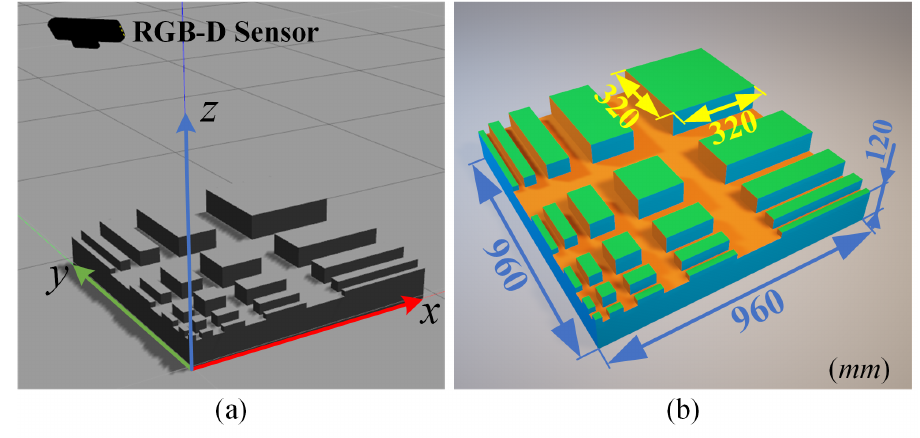
Figure 8. ( a ) The synthesized scene in Gazebo, where the pattern object is perceived by a simulated RGB-D sensor. The edges of the object’s base are respectively aligned with the x and y axes of the reference frame, while the edge orthogonal to those is aligned with the z axis. ( b ) The geometric features of the pattern